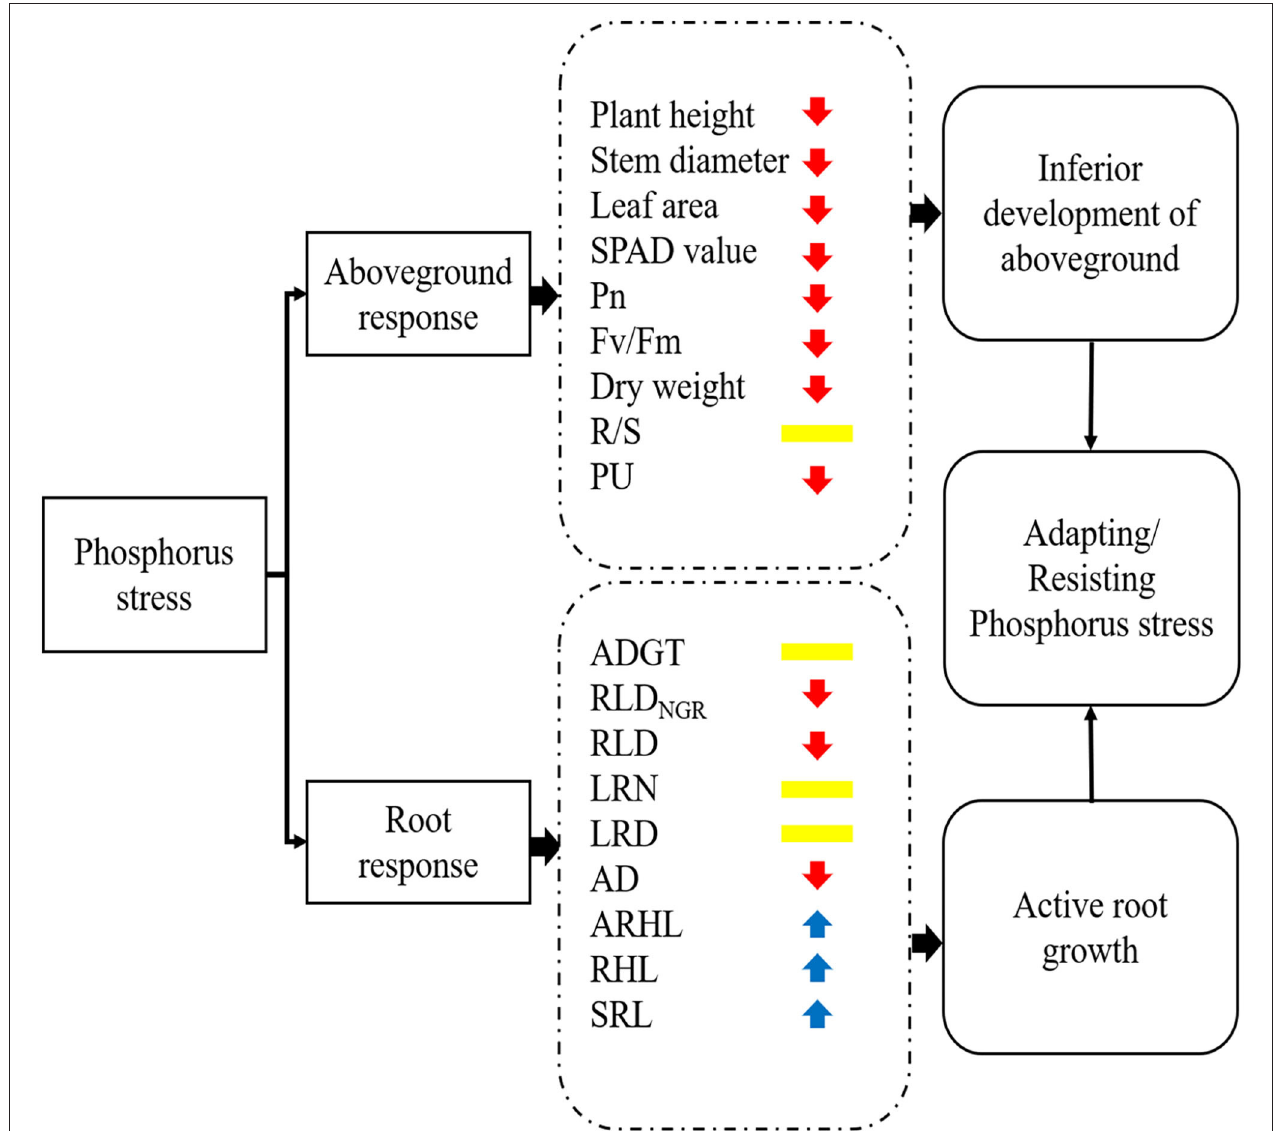
FIGURE 11 | A working model of the response of cotton to phosphorus stress. The colors of arrows indicate that the morphological/physiological indicators were increased (blue) or decreased (red) or not significantly different (yellow) under phosphorus stress. Pn, net photosynthetic rate; F v / F m , maximum photochemical efficiency; R/S, root/shoot ratio; PU, phosphorus uptake; ADGT, average daily growth of taproots; RLD NGR , net growth rate per unit volume; RLD, root length density per unit volume; LRN, number of lateral roots; LRD, lateral root branching density; AD, average root diameter; ARHL, average root hair length; RHL, root hair life span; SRL, specific root